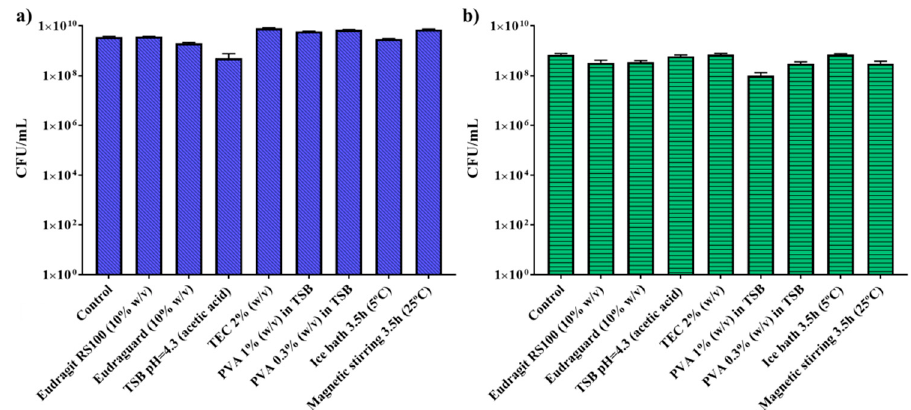
Figure 2. Bacteria viability after polymers, encapsulation media, and synthesis conditions treatment in Escherichia coli ( a ) and Lactobacillus acidophilus ( b ). Results were obtained from two independent syntheses assayed in triplicate.